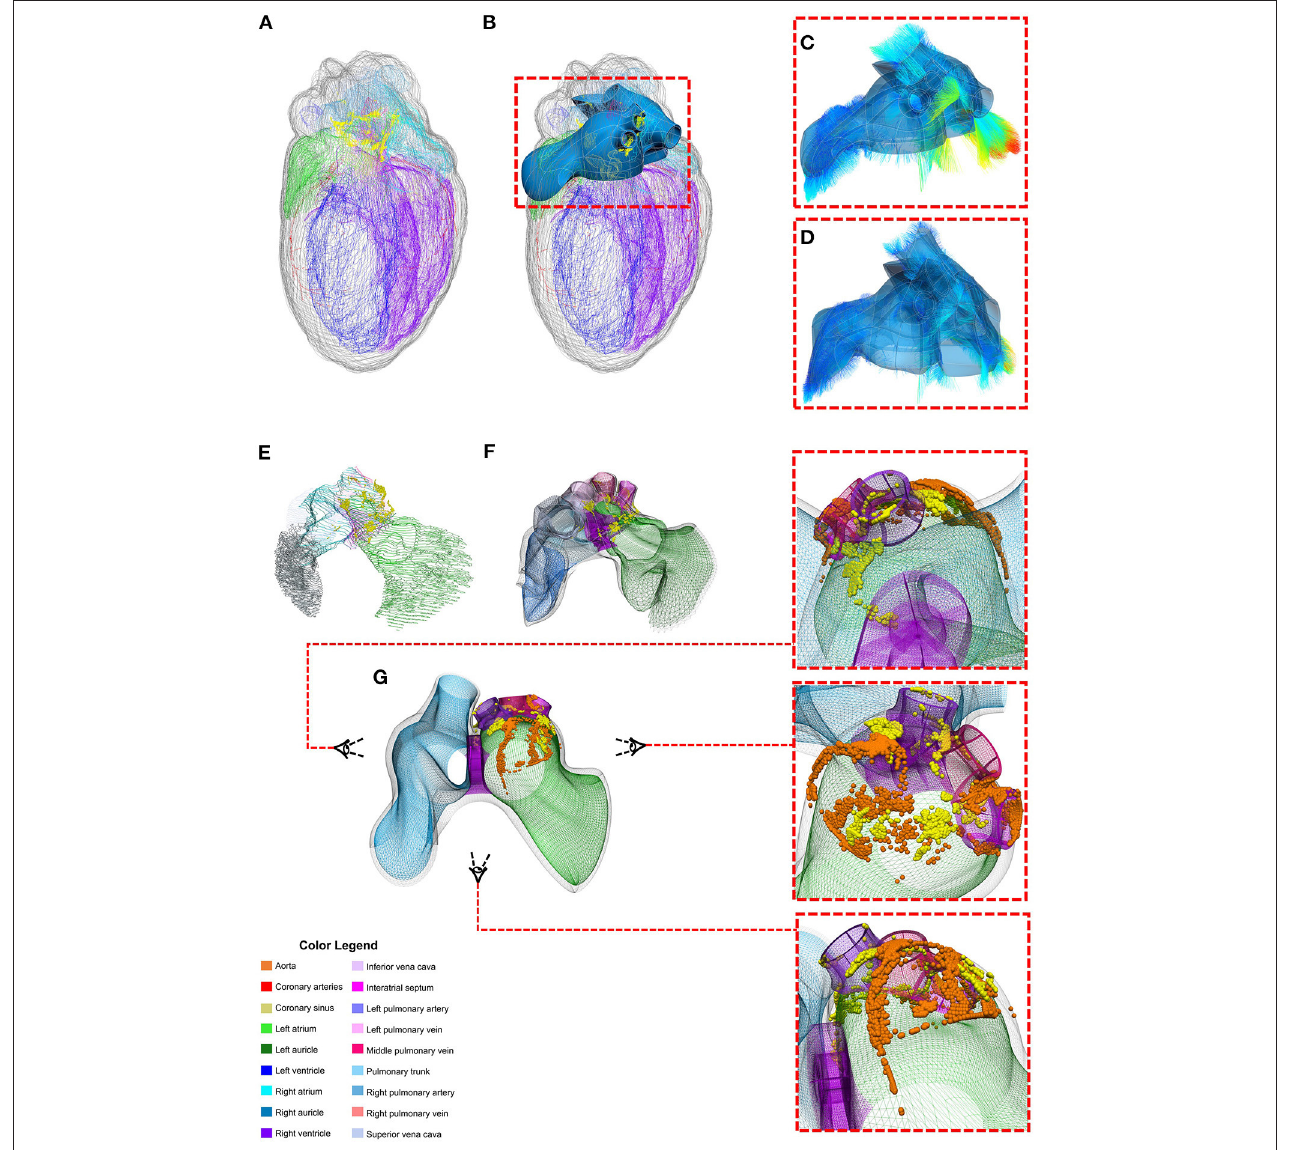
FIGURE 9 | Mapping individual rat ICNs and cardiac anatomy onto a generalized 3D scaffold for comparison across animals through an automated pipeline. (A) Segmentation contours from the imaged heart is used to (B) customize and generate the atrial scaffold; (C) individual data points from the contours are projected on the nearest scaffold surface to compute the minimum distance for the fitting process to (D) fit and morph the scaffold to match the data; (E) the atrial contour data with ICN cells are processed to (F) map and register the spatial distribution of individual cells on the scaffold as material points. This material point mapping provides a powerful way to (G) capture information from multiple subjects (e.g., orange vs. yellow spheres showing individual ICNs from two different rats) on one “generic” scaffold. Here the heart is visualized from a superior angle to appreciate how the neuron locations in the original data are projected onto the generic scaffold. Figure adapted and modified from Leung et al.